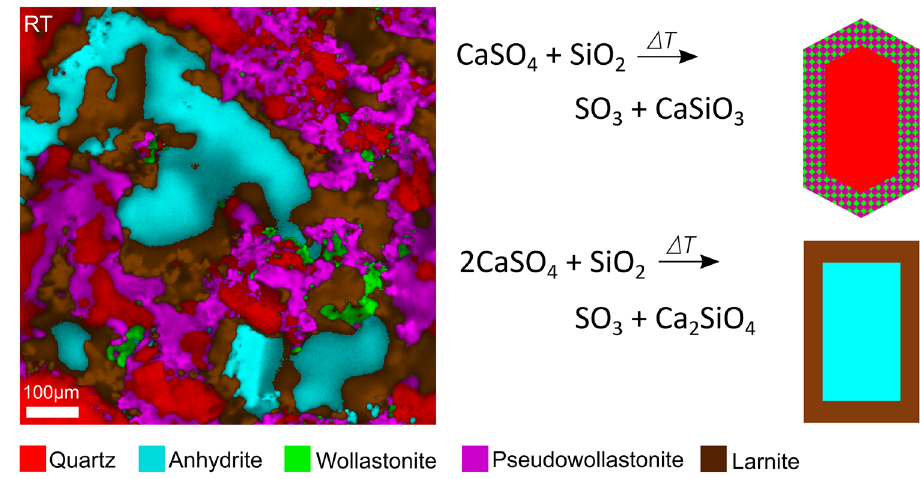
Fig. 4 Normalized false-color hyperspectral Raman images of the in situ experiment